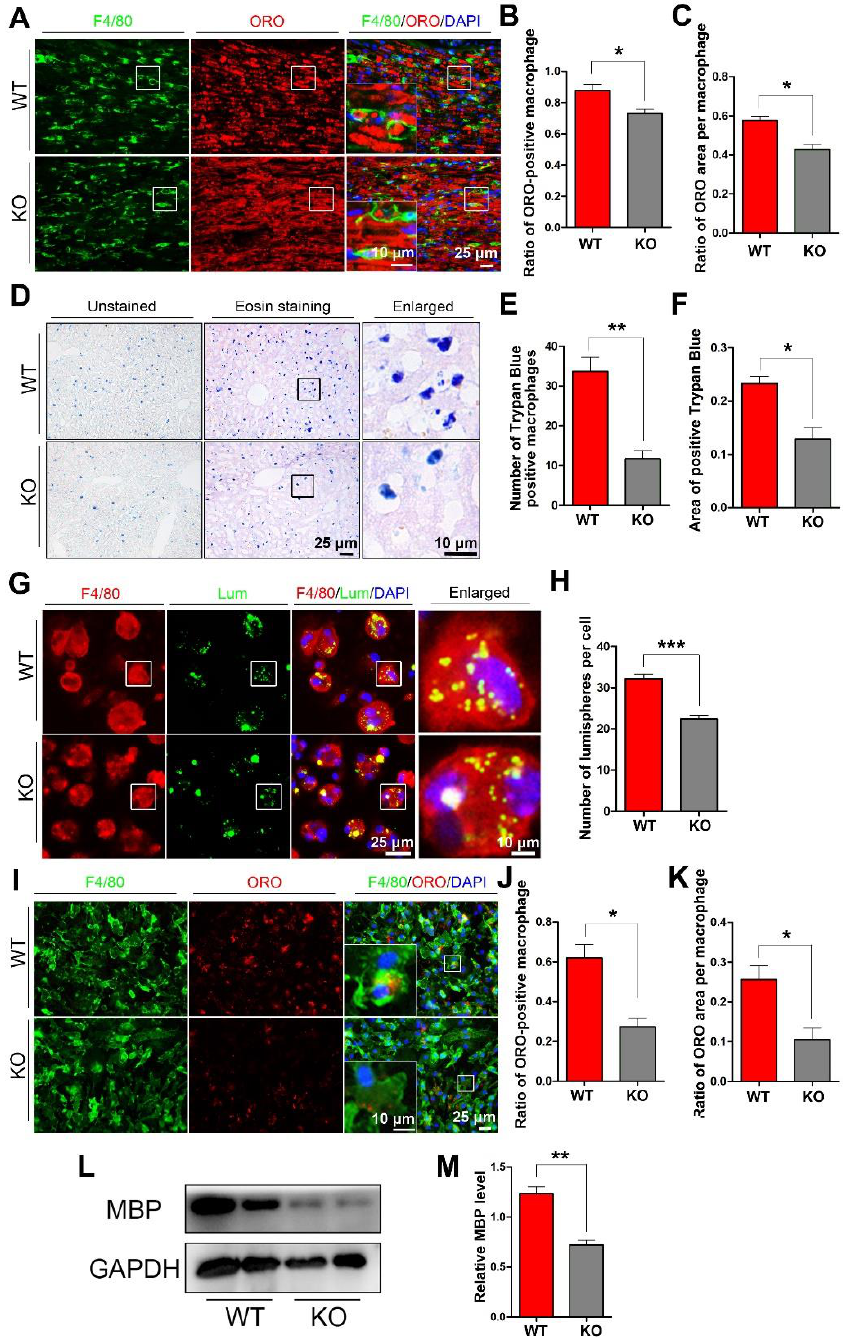
Figure 2. miR-301a knockout inhibits the phagocytosis of macrophages in vivo and in vitro. ( A ) F4/80 and ORO double staining in the transection-injured sciatic nerve at 5 dpi. ( B , C ) Quantitative analysis showing that the ratio of ORO+ macrophages and the ORO+ area in each macrophage are significantly decreased in the KO group compared to the WT group. ( D – F ) Eosin staining of liver tissue after trypan blue dye injection showing the phagocytosis of hepatic macrophages. ( G ) F4/80 immunocytochemistry with the fluorescent lumispheres and ( H ) quantification of the number of lumispheres per macrophage in vitro. ( I – K ) F4/80 and ORO double immunocytochemistry staining and quantitative analysis after the macrophages cultured with myelin debris in vitro. ( L , M ) Western blots and quantification showing that MBP expression in the KO group cultured with myelin debris is less than those in the Cre group in vitro. Data are expressed as the mean ± SEM ( n = 6 for each group, N.S: p ≥ 0.05, * p < 0.05, ** p < 0.01, *** p < 0.001).